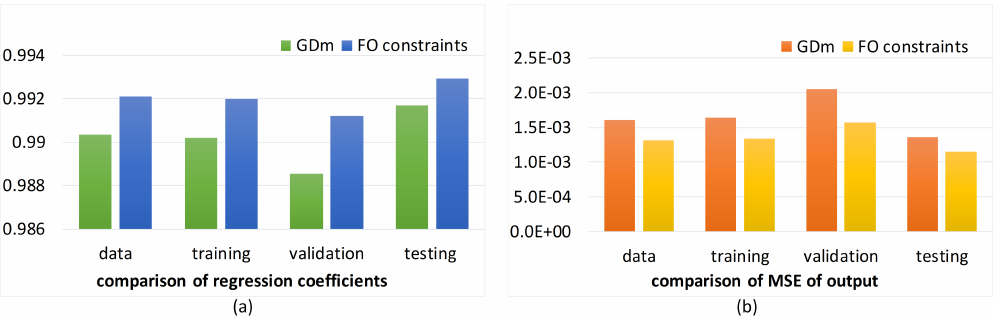
Figure 11. Comparison of output performance of fPIRNN with fractional-order constraints to RNN with GDm. ( a ) Regression coefficient and ( b ) MSE of output error. “data” means the entire dataset including training, validation, and testing data. Moreover, “training”, “validation”, and “testing” are the corresponding results of the three datasets,